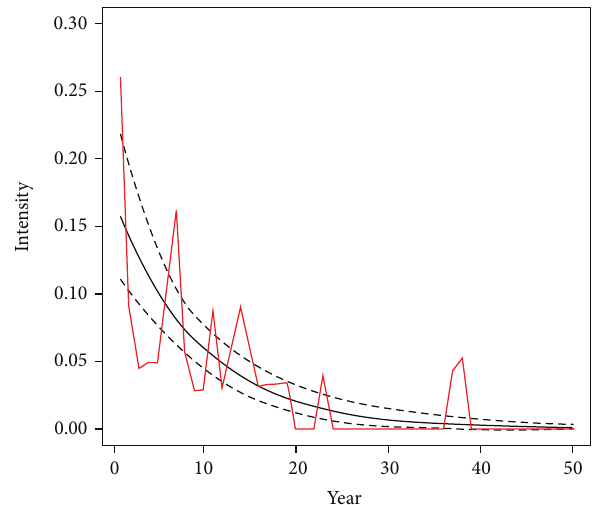
Figure 1: Intensity of sucide attempts during course of depression by years.